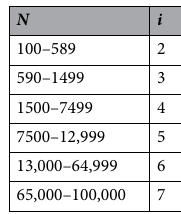
Table 1. The table shows the values of N , i.e. the order of the graph, and the values of i , the order of the complete sub-graph used as starting point, for the algorithm SM